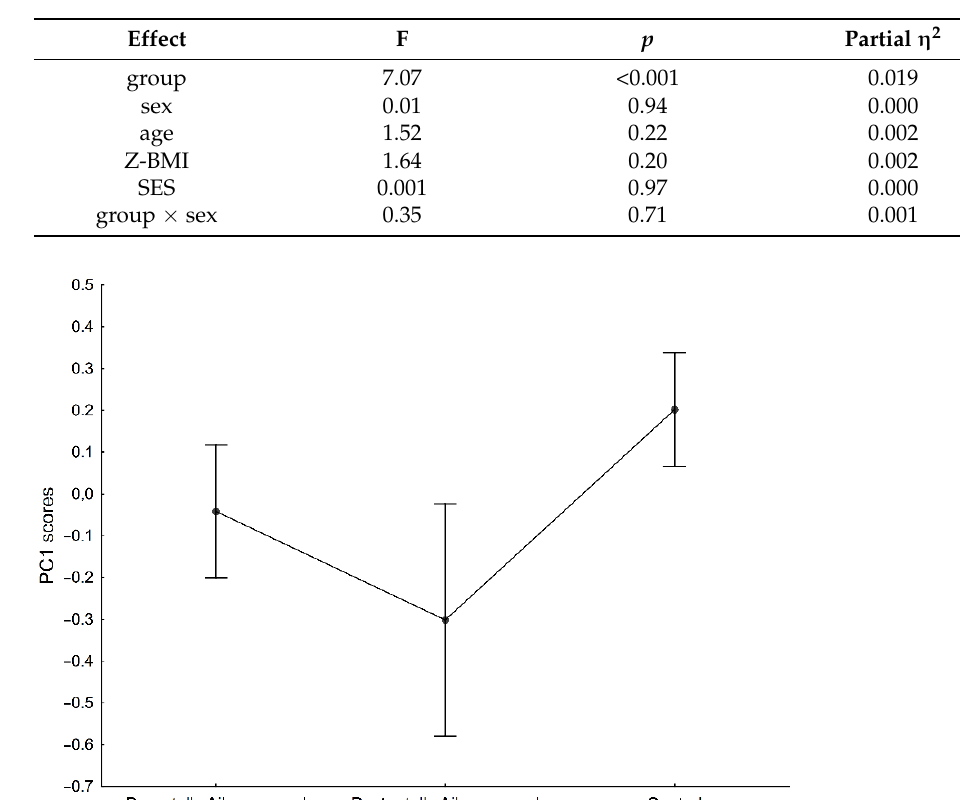
Figure 1. Differences in mean PC1 scores (a proxy for relative body fat distribution) between three studied groups. The lower the PC1 scores values, the more central-oriented the pattern of the relative subcutaneous fat distribution. Significant differences: prenatally Aila-exposed and controls ( p < 0.05), and postnatally Aila-exposed and controls ( p < 0.05).